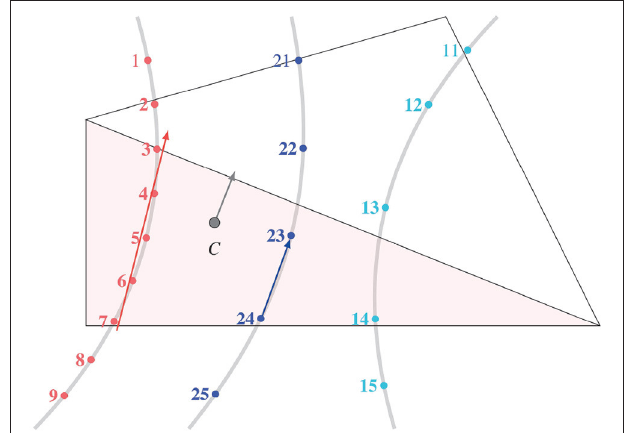
FIGURE 3 | Effective fibre direction in an element. The points within a fibre strand created by MedINRIA were sequentially numbered. When more than one fibre strand passed through an element, the effective fibre direction at the element centroid C was computed by the weighted sum of the best fit lines from each